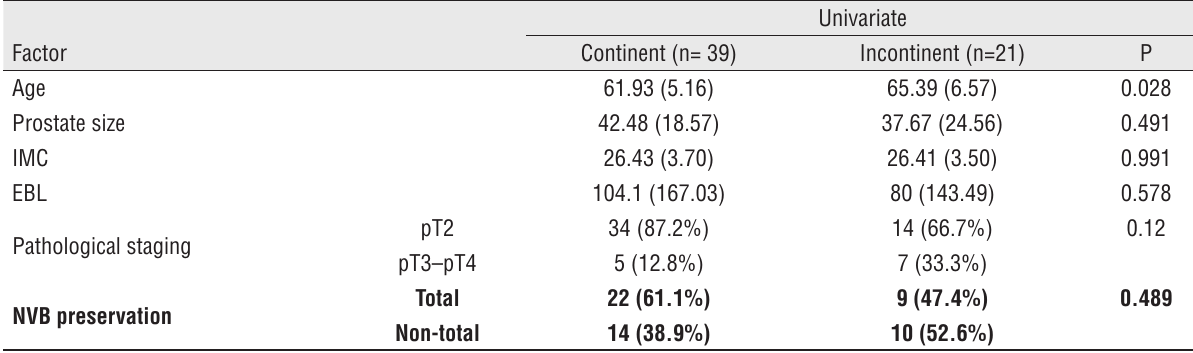
Table 6 - comparison of factors according to continence status